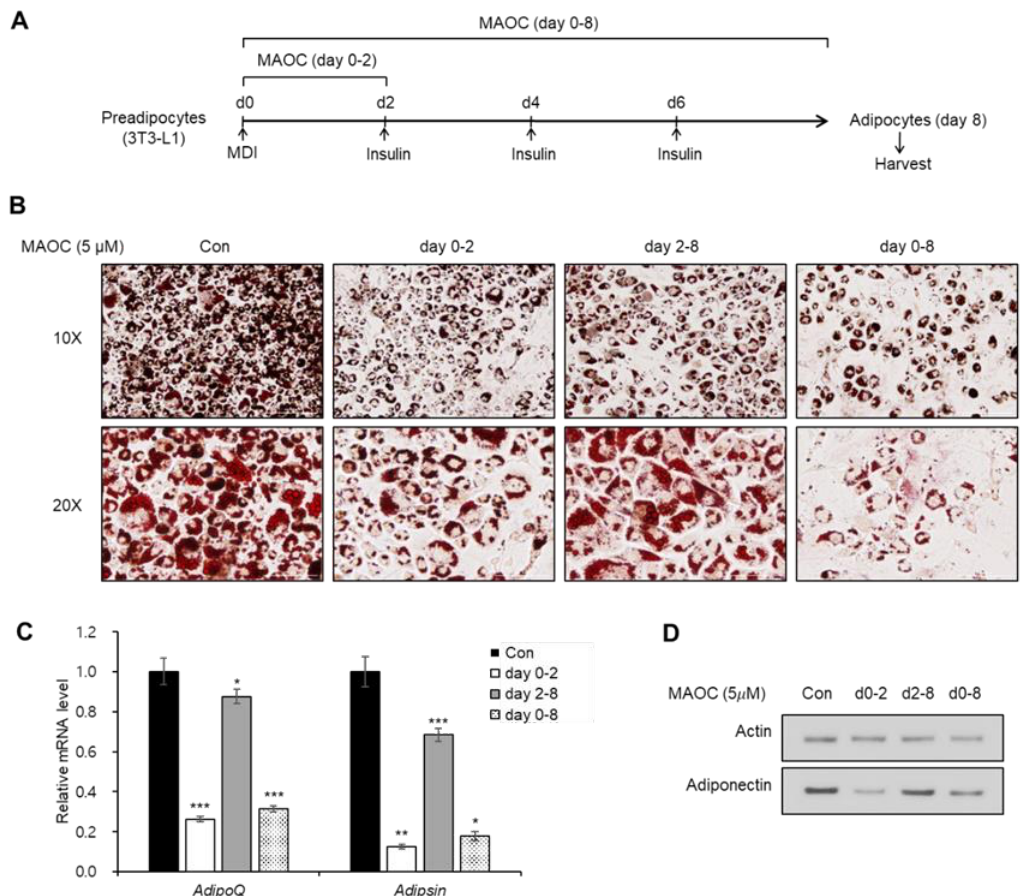
Figure 3. Inhibitory effects of morolic acid 3- O -caffeate (MAOC) on the early stage of adipogenesis. ( A ) Schematic representation of 3T3-L1 differentiation into adipocytes. Cells were treated with MAOC (5 μM) during the early days (day 0–2), late days (day 2–8), or entire period of differentiation. ( B ) Oil Red O staining of 3T3-L1 adipocytes incubated with MAOC (5 μM) during adipogenesis. ( C ) The mRNA levels of Adipoq and Adipsin genes in 3T3-L1 adipocytes incubated with MAOC (5 μM) during adipogenesis. Data present the means ± SEM for n = 3. * p < 0.05, ** p < 0.01, and *** p < 0.001. ( D ) Western blot analysis of 3T3-L1 adipocytes incubated with MAOC (5 μM) during adipogenesis.